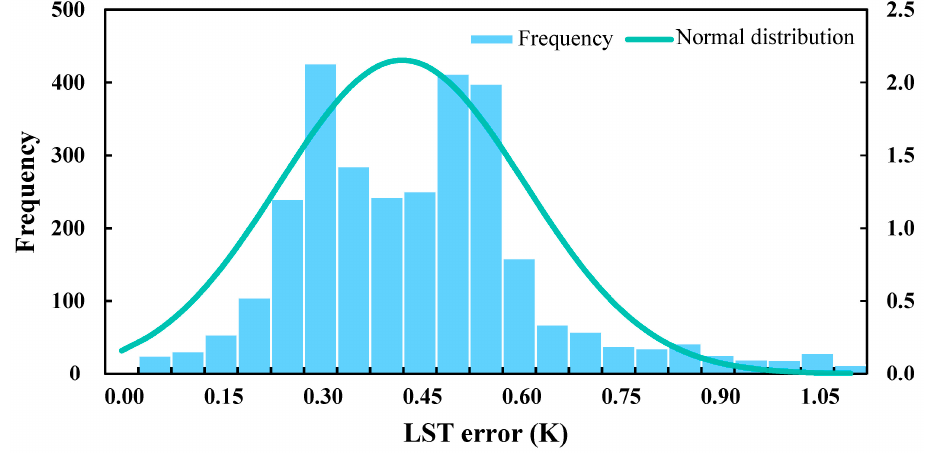
Figure 12. Error distribution frequency and normal distribution curve for the SW algorithm.